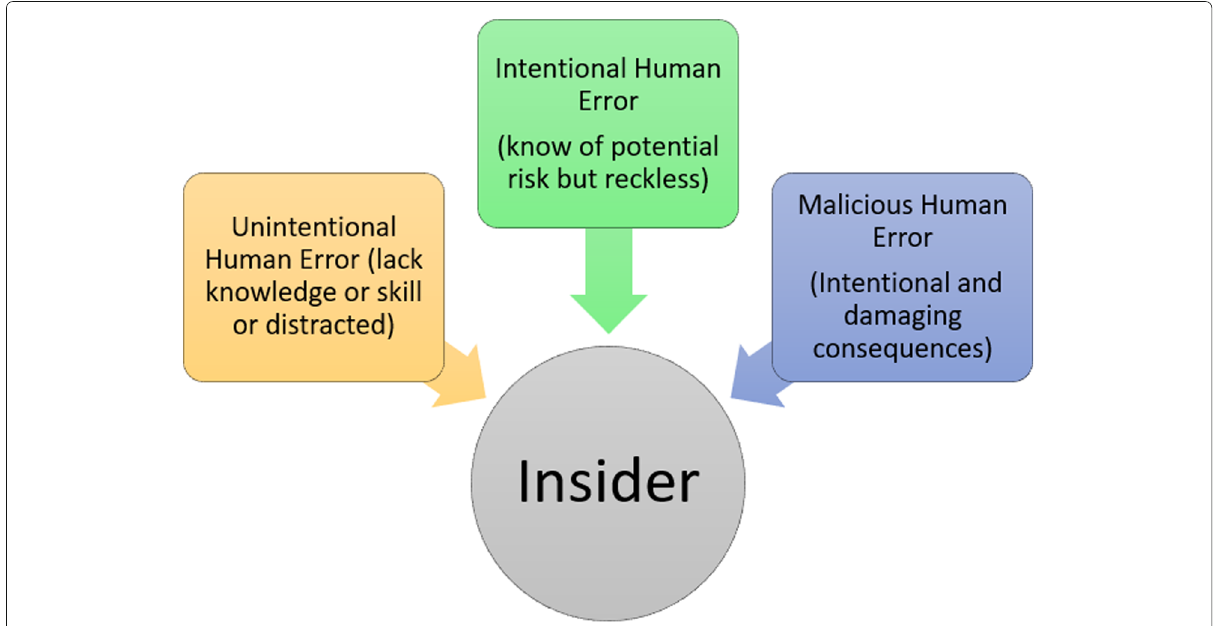
Fig. 3 Proposed UIM human error as insider-anomaly